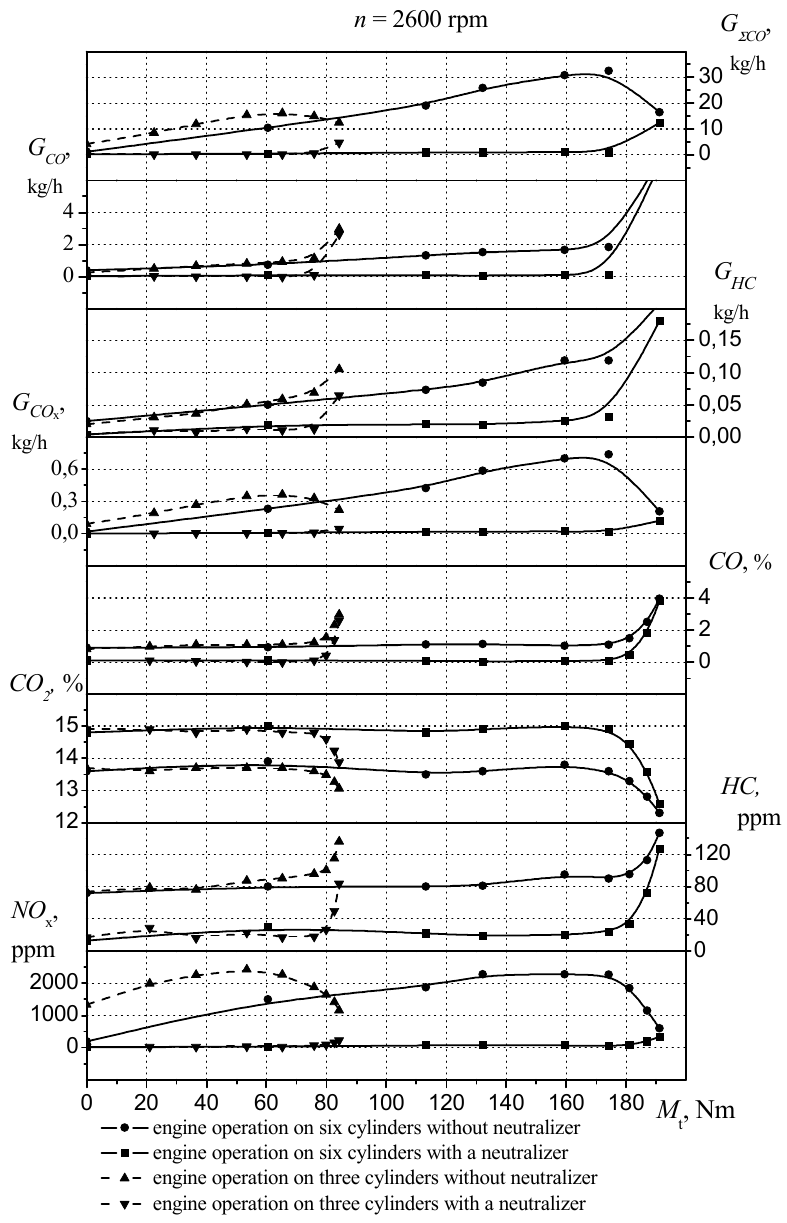
Figure 8. Load characteristics of the Opel C30 LE engine at n = 2600 rpm operating with three and six cylinders (environmental indicators).